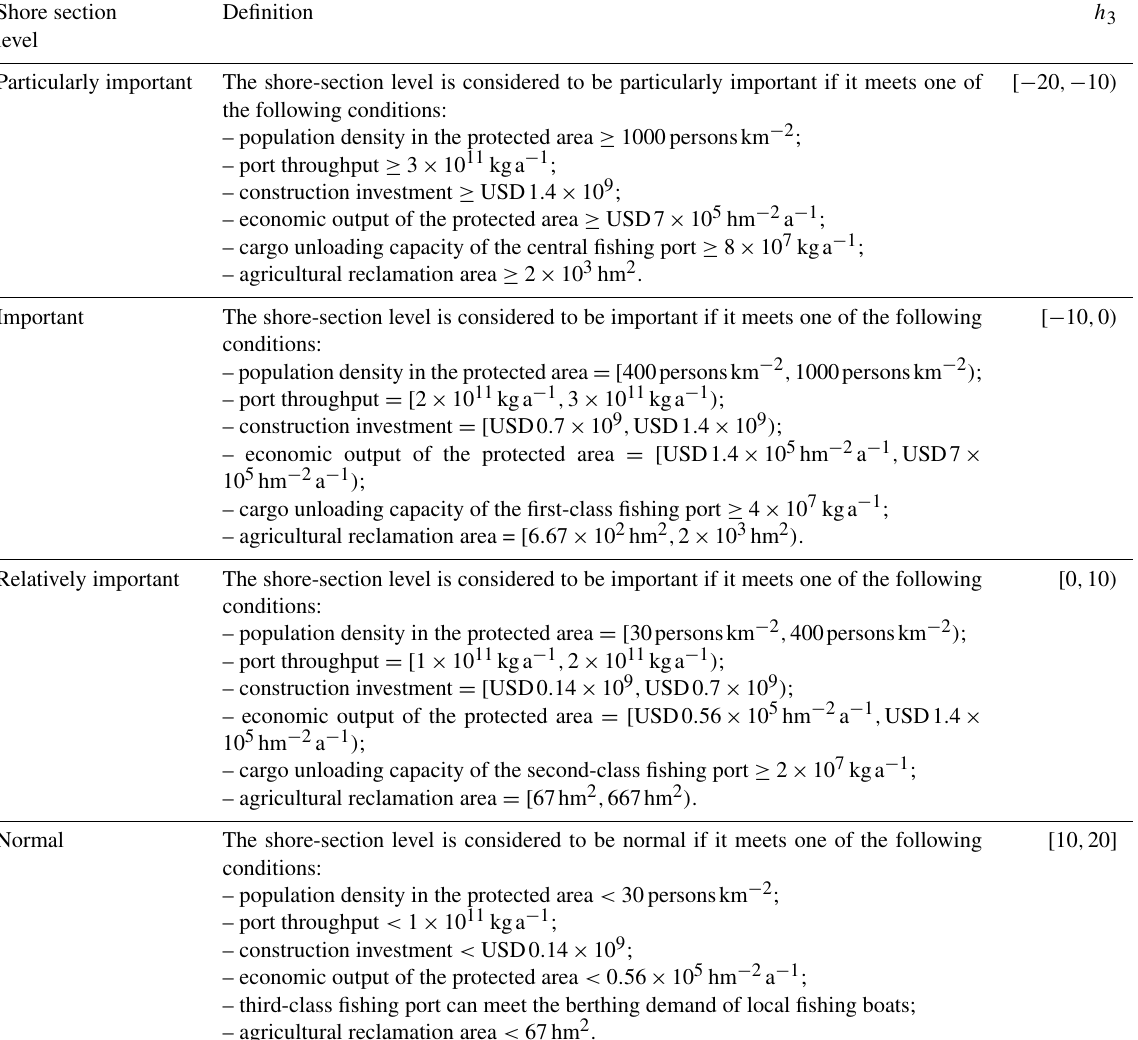
Table note: the shore-section level is categorized into four grades: particularly important, important, relatively important, and normal. Each grade is mainly judged from six criteria; as long as one of the criteria is met, the shore-section importance level can be considered to be this grade. The six criteria are population density, port throughput, construction investment, economic output, cargo unloading capacity, and agricultural reclamation area. The value of h 3 can be taken as ( − 20)–20.